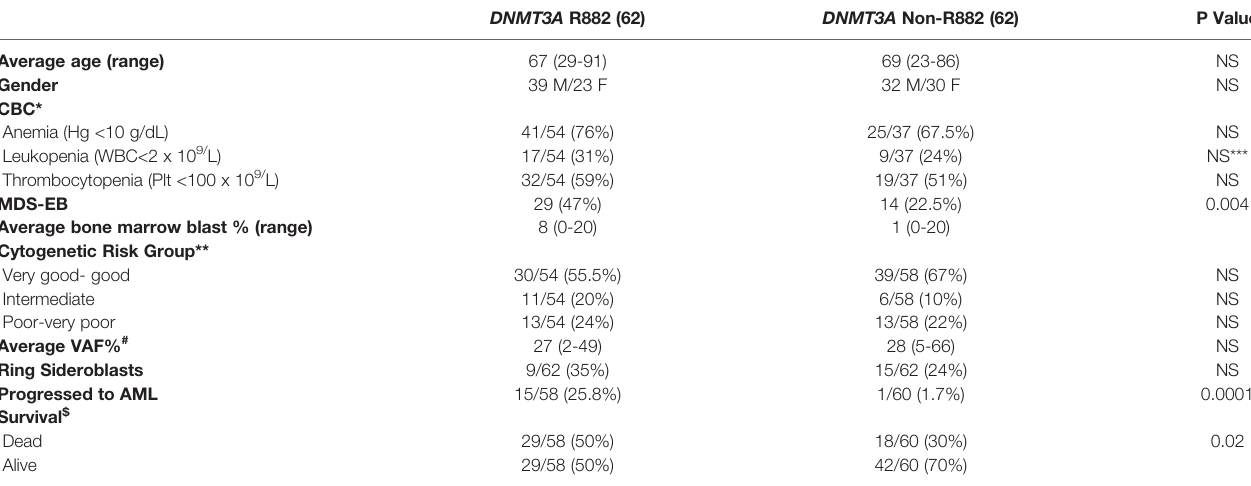
TABLE 2 | Summary of the clinicopathologic features of DNMT3A (R882 vs. Non-R882) mutations in myelodysplastic